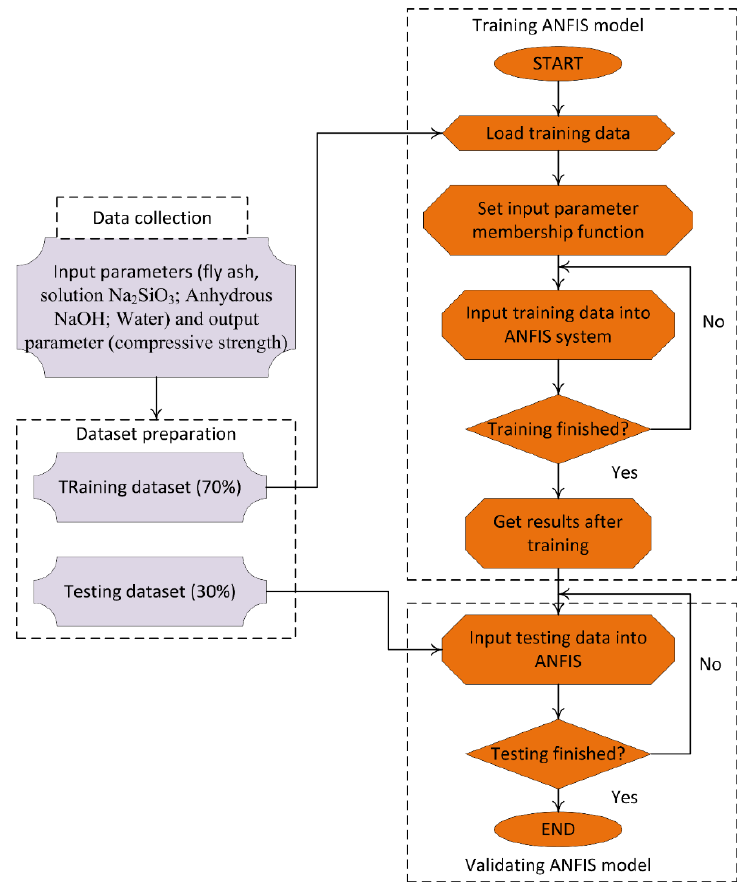
Figure 4. Methodology of development of an efficient ANFIS model [54]. Reprinted with permission from [54]. 2013, Hue-Yu Wang et al.